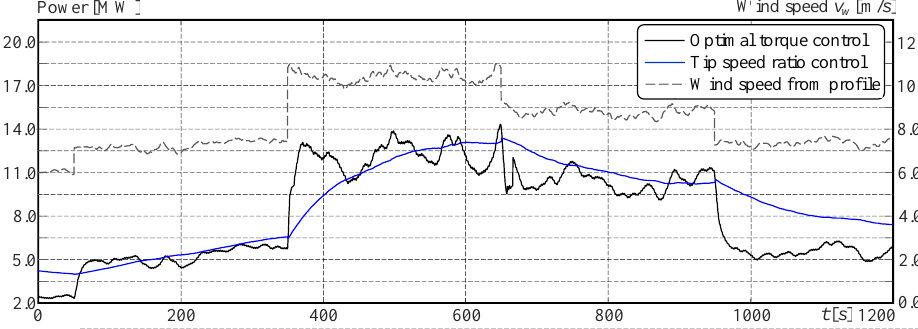
Figure 8. Time series of the extracted power under the control system in partial load operation.